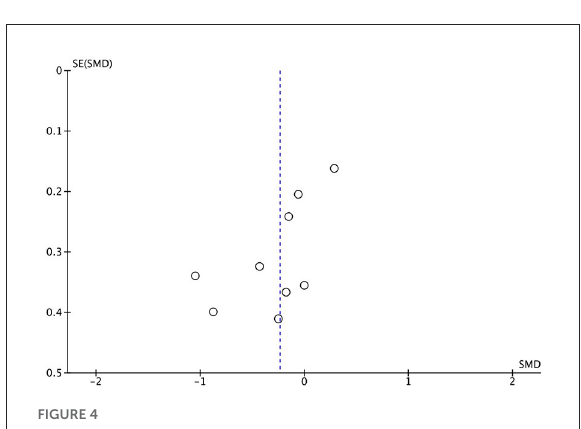
Meta-analyses of cognitive outcome